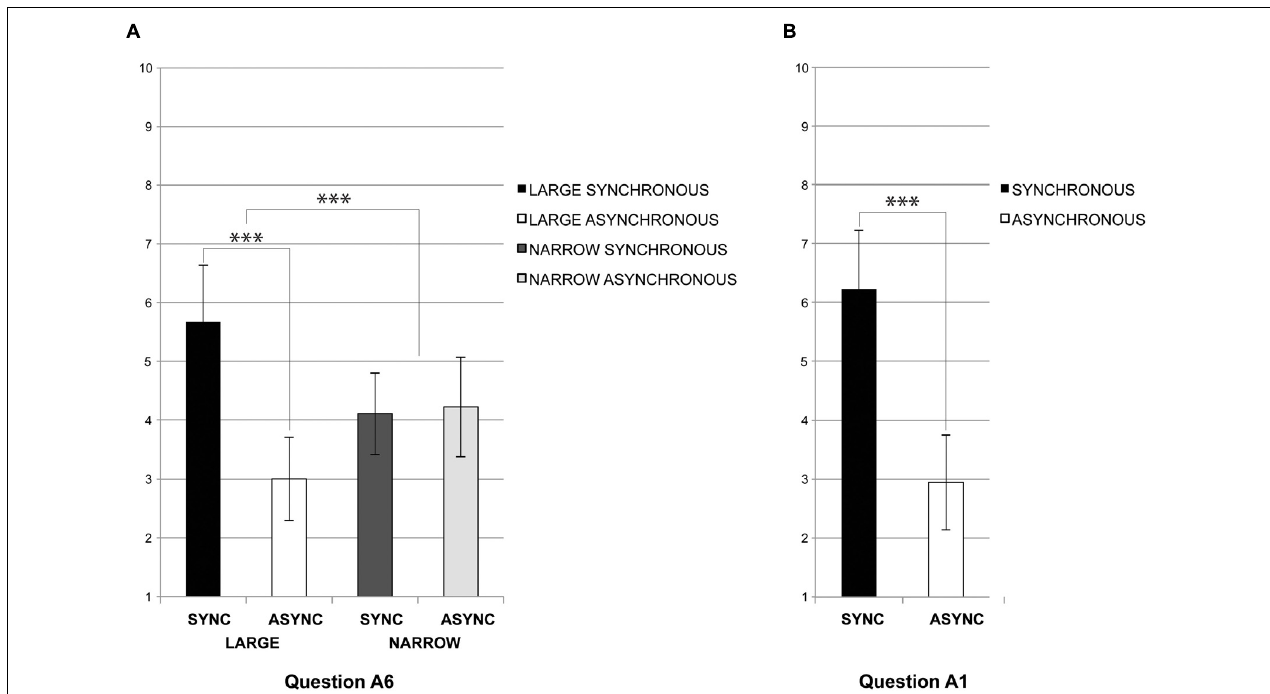
FIGURE 5 | Experiment 2 – Questionnaires. (A) Significant two-way interaction effects between stimulation and interior in Experiment 2 from ANOVAs in self-consciousness Question A6: “The touch I felt came from somewhere between my own body and the virtual enclosure.” ( ∗ p < 0.05; ∗∗ p < 0.01; ∗∗∗ p < 0.005). The plots are based on the average response calculated with non-normalized data; error bars represent standard errors. (B) Significant main effects of stimulation in Experiment 2 from ANOVAs in self-consciousness Question A1, visuotactile congruency effect : “I could locate the touch of the stick in the location where I saw the virtual wall being touched.” ( ∗ p < 0.05; ∗∗ p < 0.01; ∗∗∗ p < 0.005). The plots are based on the average response calculated with non-normalized data; error bars represent standard